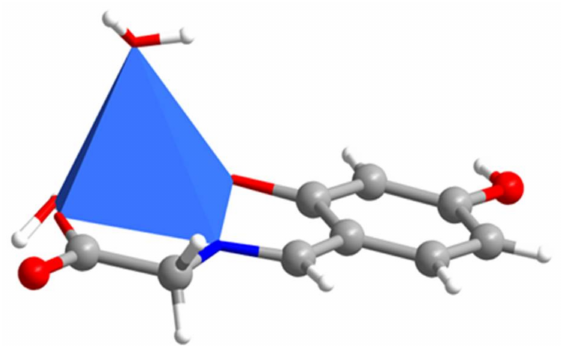
Figure 3. The polyhedron of Complex 1 .